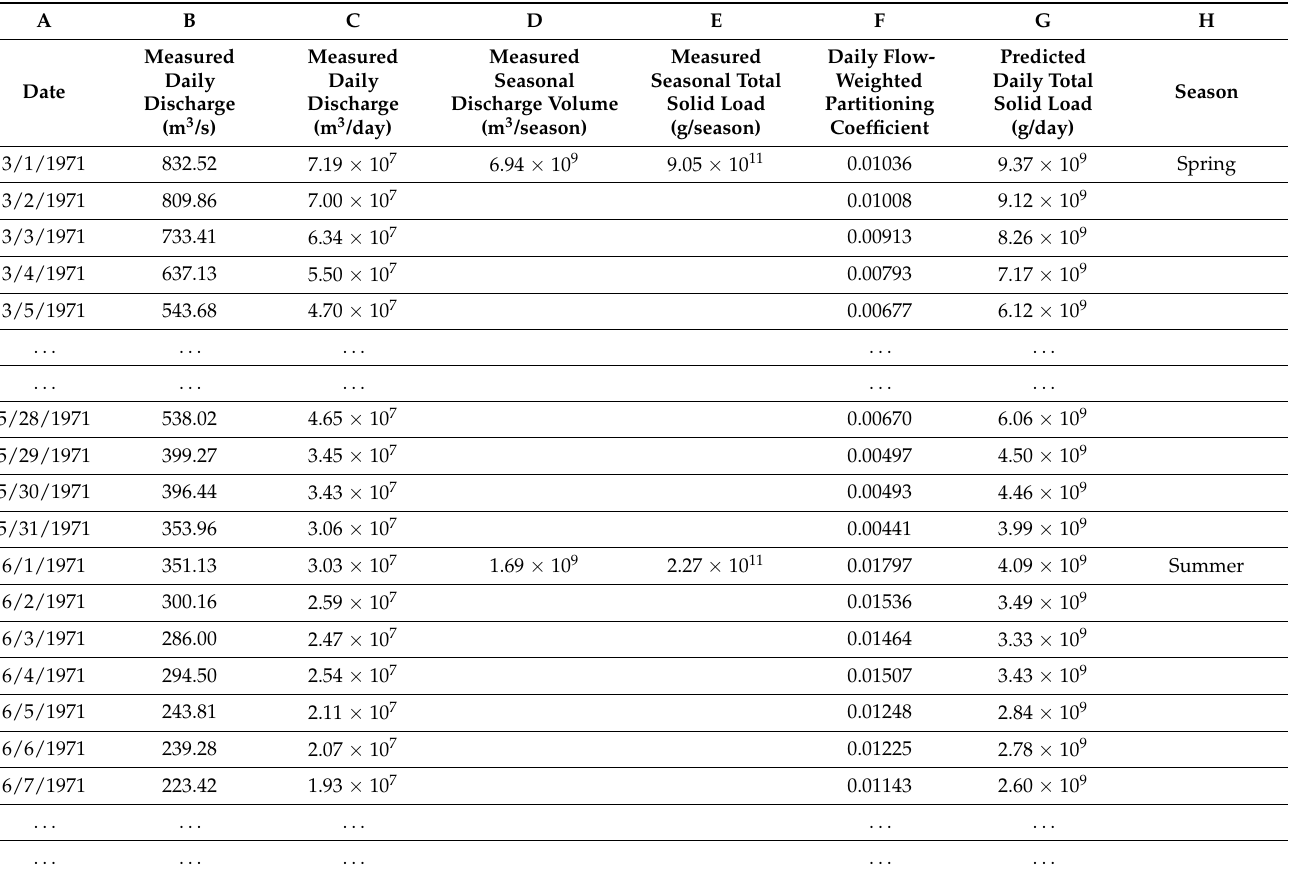
Table 3. Calculated partitioning coefficients and predicted daily total solid loads for Station